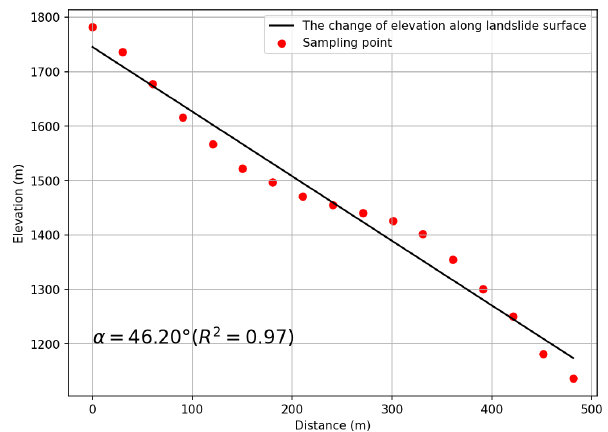
Figure 12. The change in elevation across the landslide surface in the case of the Hongshiyan landslide